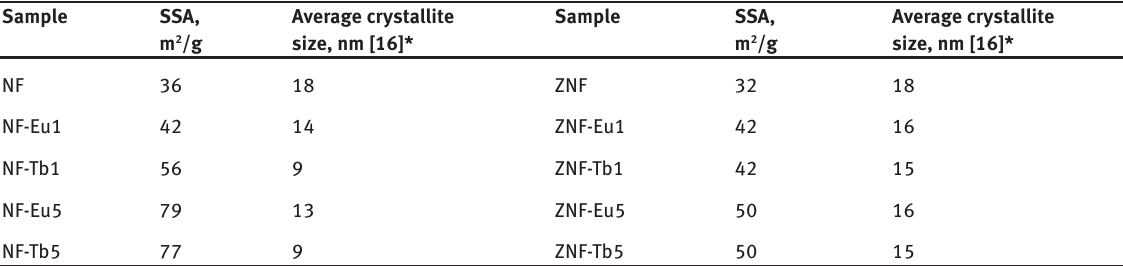
Table 1: Specific surface area (SSA) and average crystallite size of the samples.